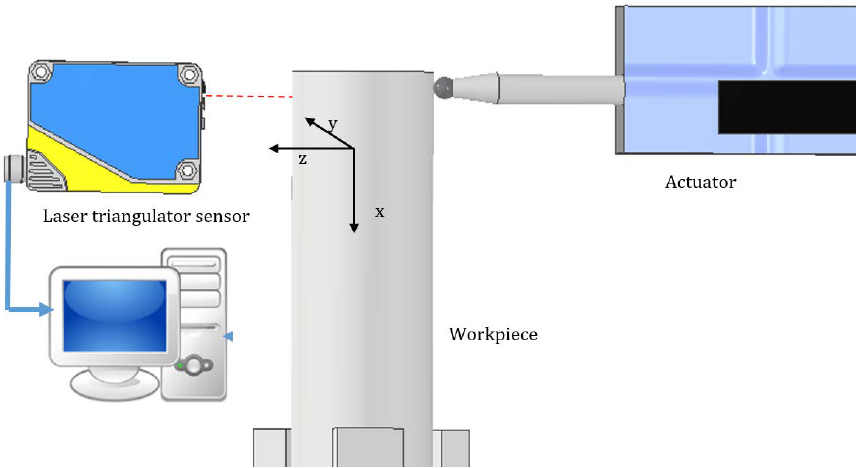
Figure 4. Scheme of the workpiece measuring station along the z axis.